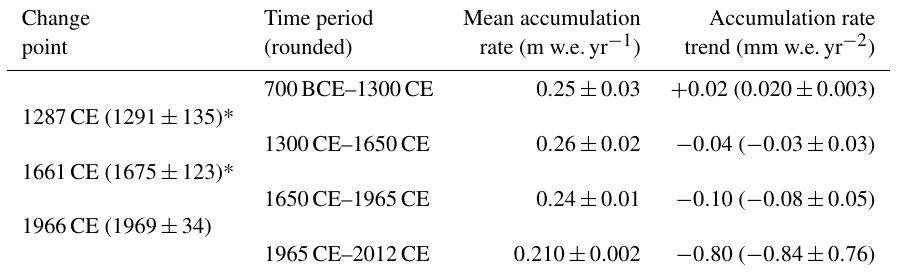
Table 3. Mean value and trends in RICE accumulation rates during various time periods. Change points and trends are found using break-fit regression (Mudelsee, 2009). The most likely change points and trend values are provided, as are the associated confidence intervals (in parenthesis: median and median absolute deviation) determined from block bootstrap analysis. Uncertainties (95% confidence intervals) of mean accumulation rates are calculated based on the uncertainty in the accumulation reconstruction. Accumulation trend estimates from the bootstrap analysis (in parenthesis) include uncertainties in the determination of the change point but not uncertainties associated with the derived accumulation rate history. The analysis does not account for a potential bias due to ice divide migration, which may slightly affect the mean accumulation rate values prior to 1750CE and the trend during the period of divide migration ( ∼ 1500–1750CE). Change Time period Mean accumulation